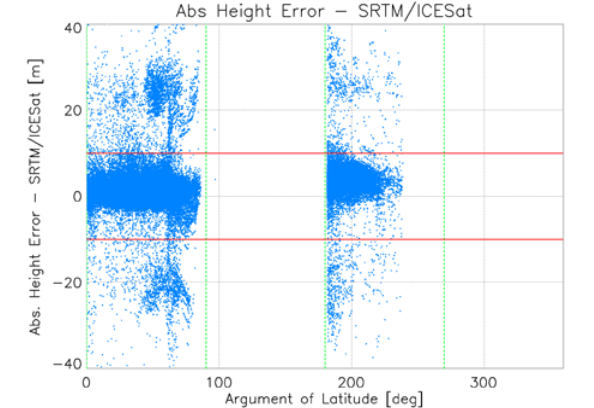
Figure 4: Height error monitoring and detection of